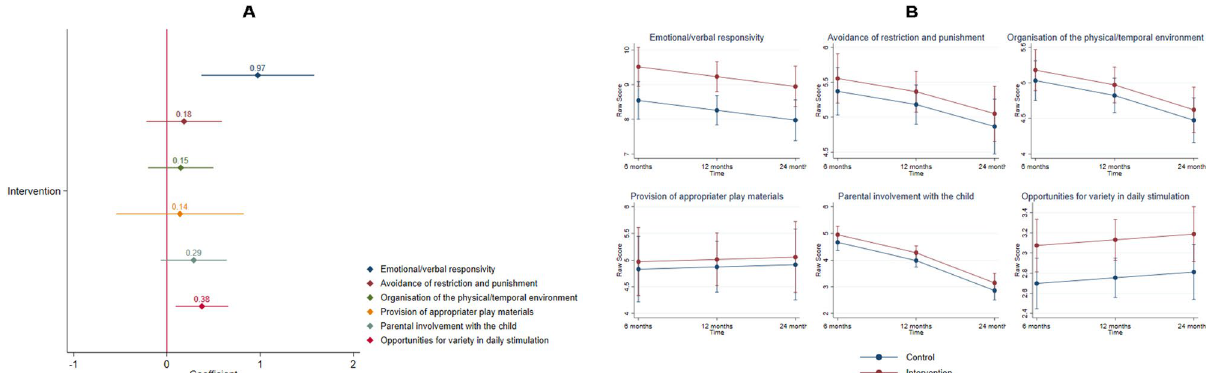
Figure 5. Intervention effects on mother–child relationship and home environment measured by the HOME (intervention n = 30, control n = 32). ( A ) Generalized estimating equations models results had the following parameters for each HOME domain: emotional/verbal responsivity (coefficient = 0.97, 95% CI [0.37, 1.58], p = 0.002), avoidance of restriction and punishment (coefficient = 0.18, 95% CI [− 0.22, 0.59], p = 0.372), organization of the physical/temporal environment (coefficient = 0.14, 95% CI [− 0.20, 0.49], p = 0.406), provision of appropriate play materials (coefficient = 0.14, 95% CI [– 0.54, 0.82], p = 0.687), parental involvement with the child (coefficient = 0.28, 95% CI [– 0.06, 0.64], p = 0.110), opportunities for variety in daily stimulation (coefficient = 0.37, 95% CI [0.09, 0.66], p = 0.009). ( B ) Fitted models plots of all HOME domains over time